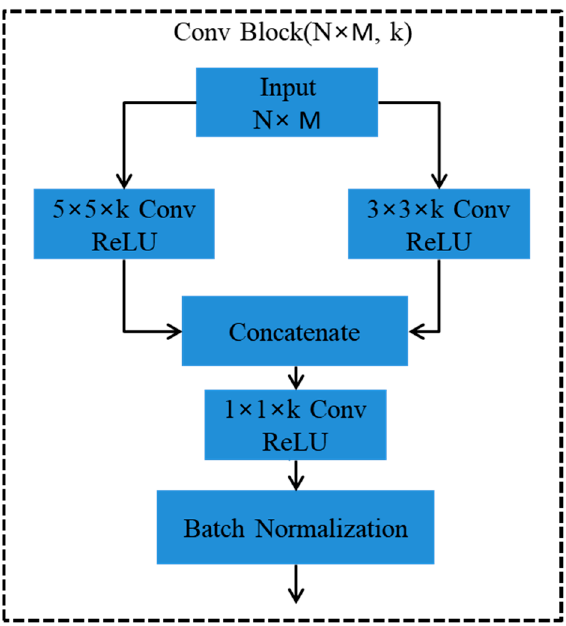
Figure 2. Internal architecture of conv blocks (i.e., B1). The input passes through two 5 × 5 and 3 × 3 convolutional layers; the output is concatenated in the proceeding